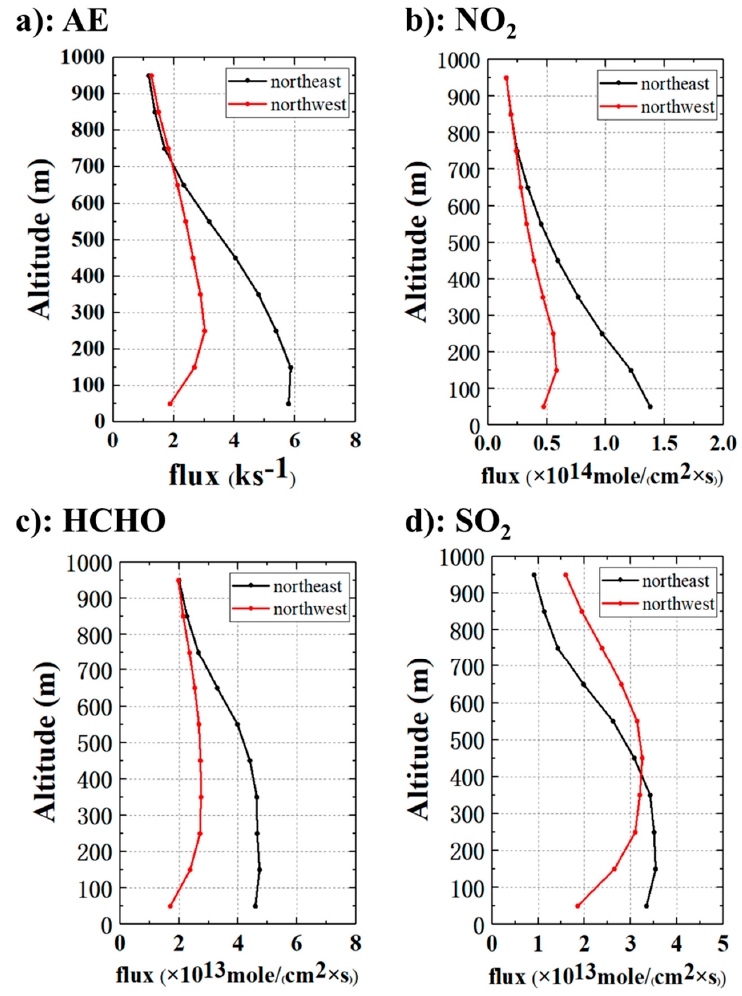
Figure 6. Vertical structure of transport flux in the boundary layer for the northeast and the north- west directions, for ( a ) aerosol extinction, ( b ) NO 2 , ( c ) HCHO and ( d ) SO 2 .